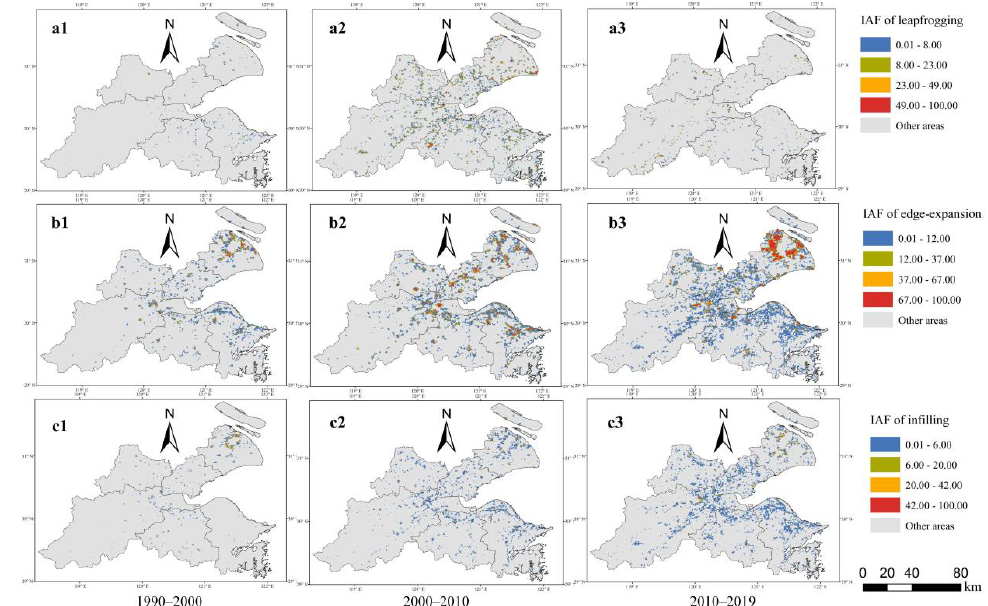
Figure 7. Spatial distributions of expansion intensity of urban expansion forms in SHB from 1990 to 2019: ( a ) Leapfrogging; ( b ) Edge-expansion; ( c ) Infilling.